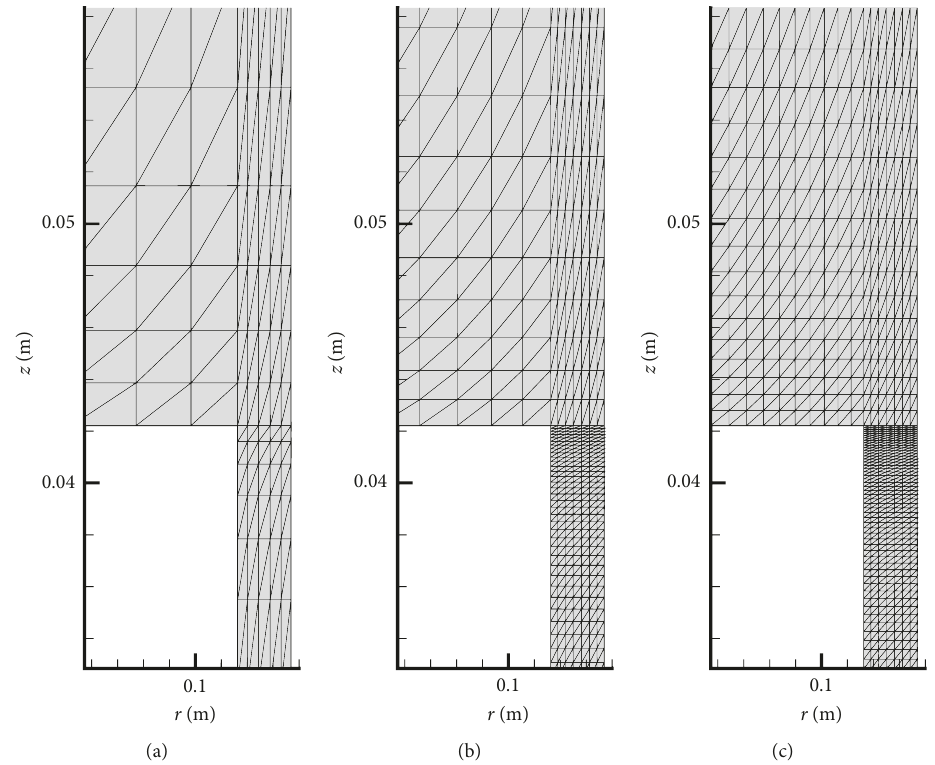
Figure 9: Close view of FEM meshes. (a) Coarse mesh. (b) Normal mesh. (c) Fine mesh.